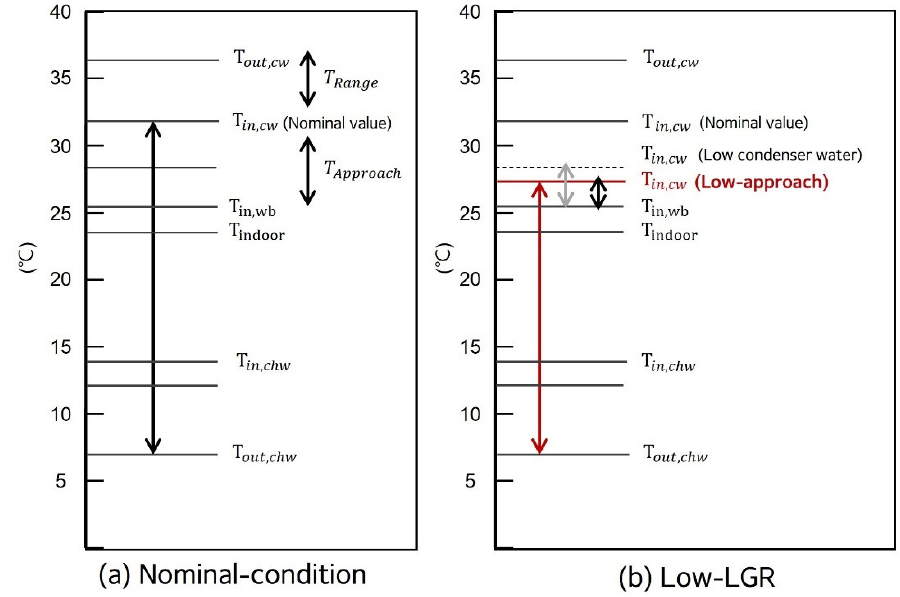
Figure 1. Comparison of typical temperature ( a ) nominal-condition and ( b ) proposed low-LGR.